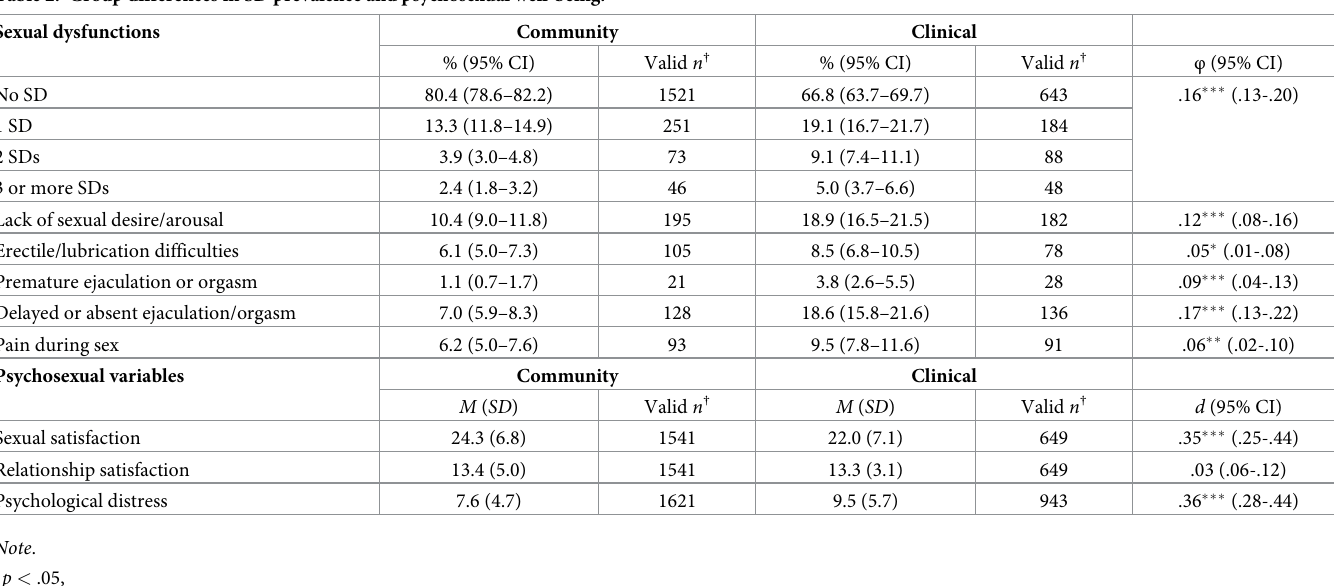
Table 2. Group differences in SD prevalence and psychosexual well-being. Sexual